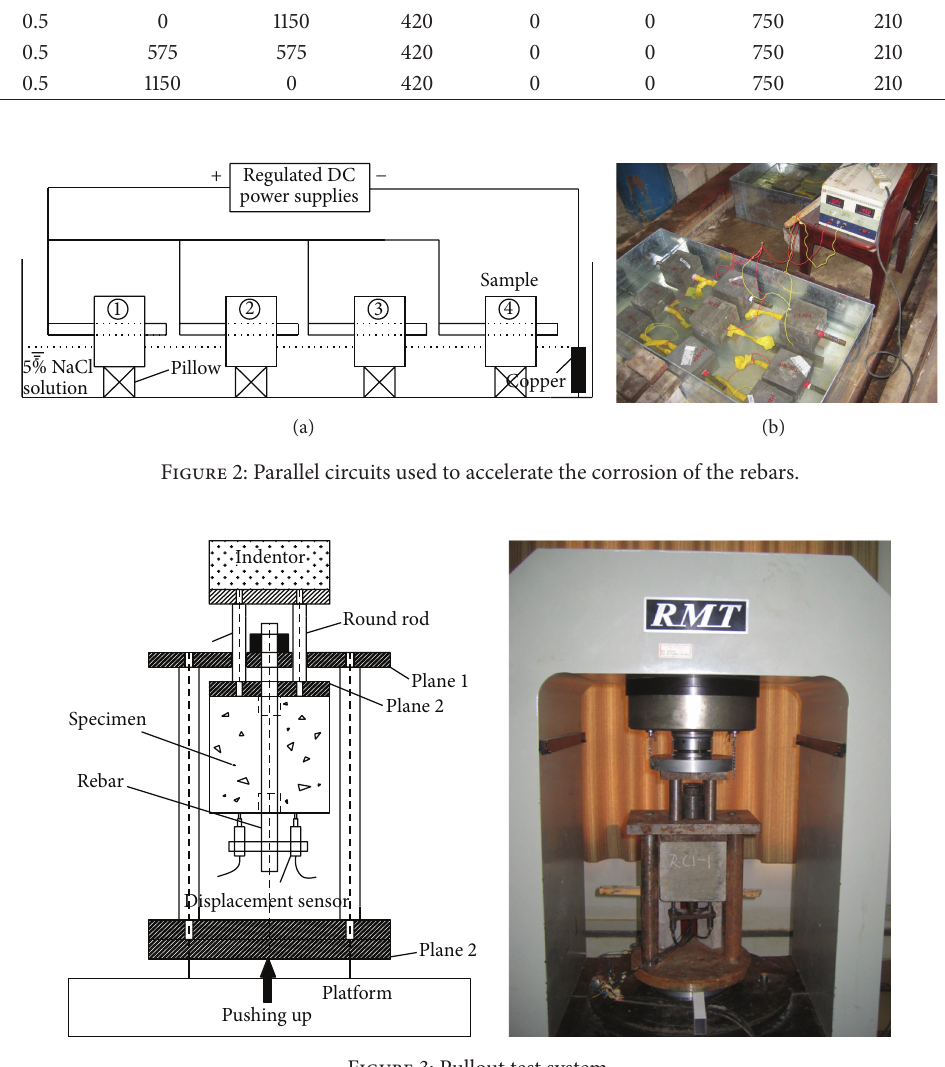
Figure 3: Pullout test